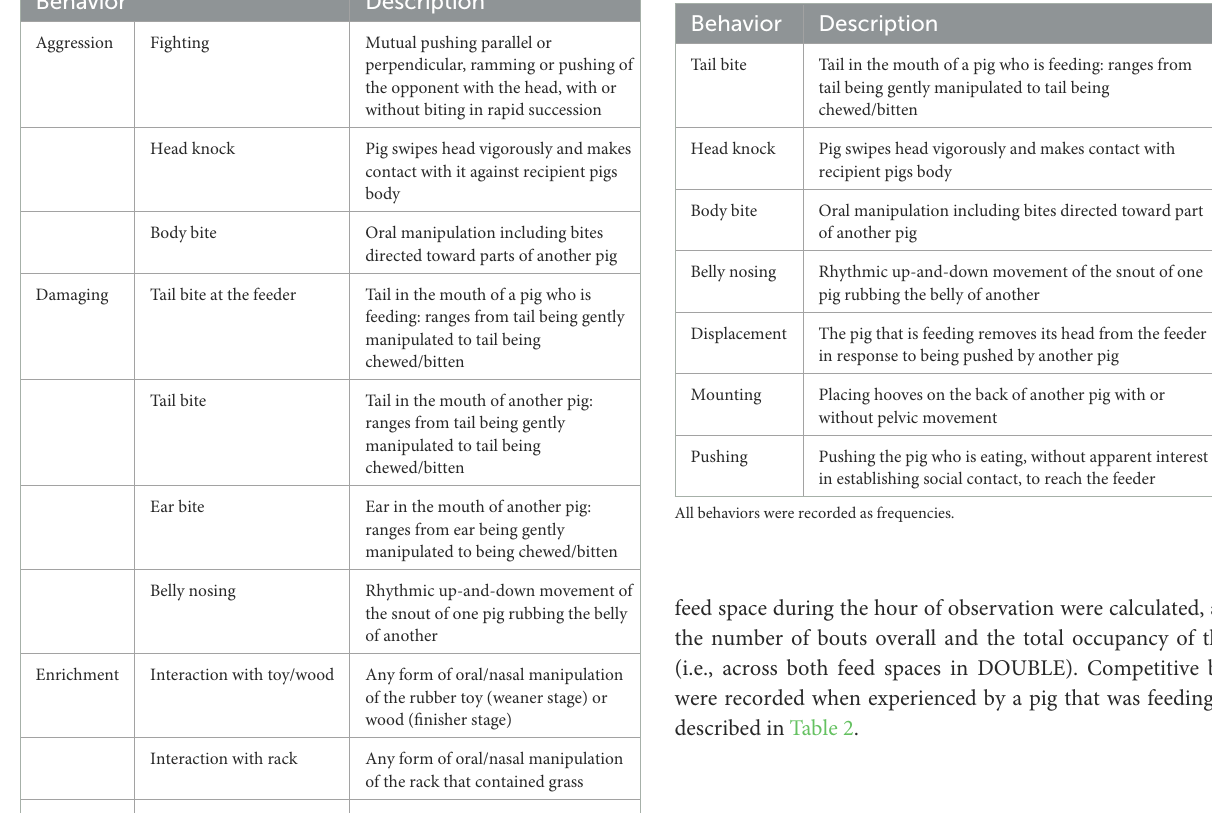
TABLE 2 Ethogram for damaging behaviors experienced by pigs while feeding. Behavior